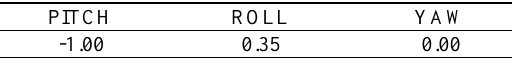
Figure 5: Patch test survey lines. Table 2: The patch test